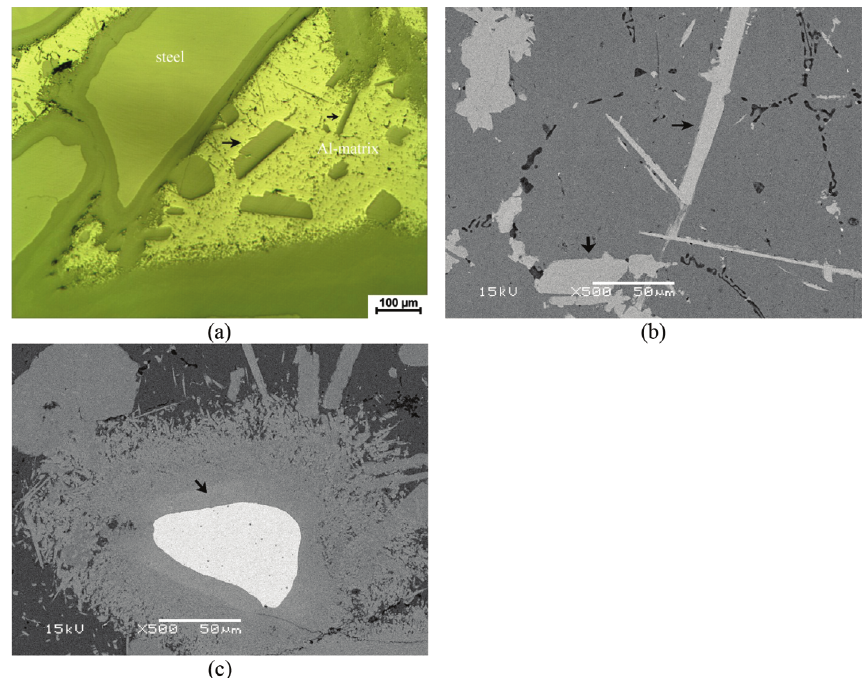
Figure 3: (a) LM and (b and c) SEM micrographs showing the composite